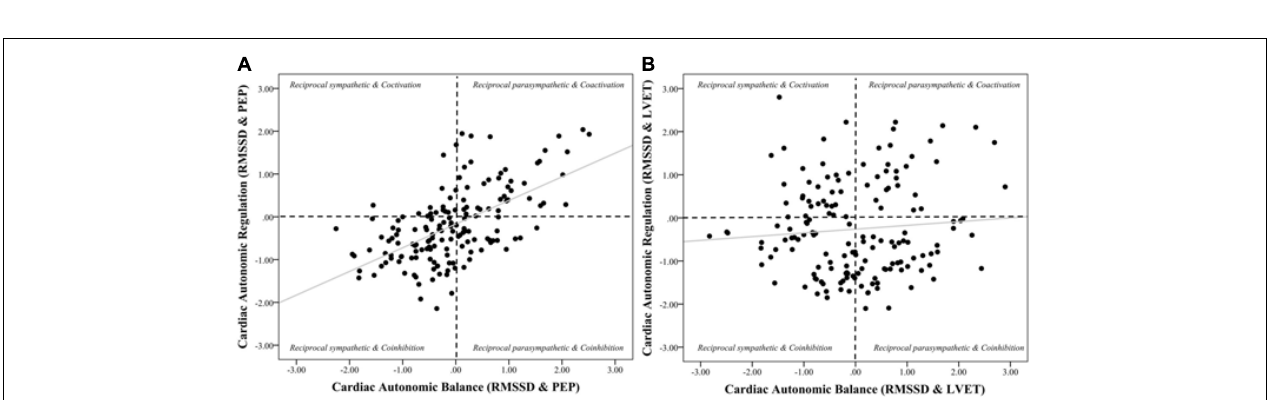
FIGURE 4 | Scatterplots of cardiac autonomic balance and regulation computed using RMSSD-HRV and both PEP and LVET. Note. ( A ) depicts the strong significant association between cardiac autonomic balance (CAB) and regulation (CAR) calculated using high frequency heart rate variability (HF) and pre-ejection periods (PEP) ( r = 0.59, p < 0.001). ( B ) depicts the lack of an association between CAB and CAR calculated using left ventricular ejection time (LVET) ( r = 0.08, p = 0.28). The correlation coefficient between CAR and CAB computed using PEP was significantly stronger than when computed using LVET ( z = 5.26, p <